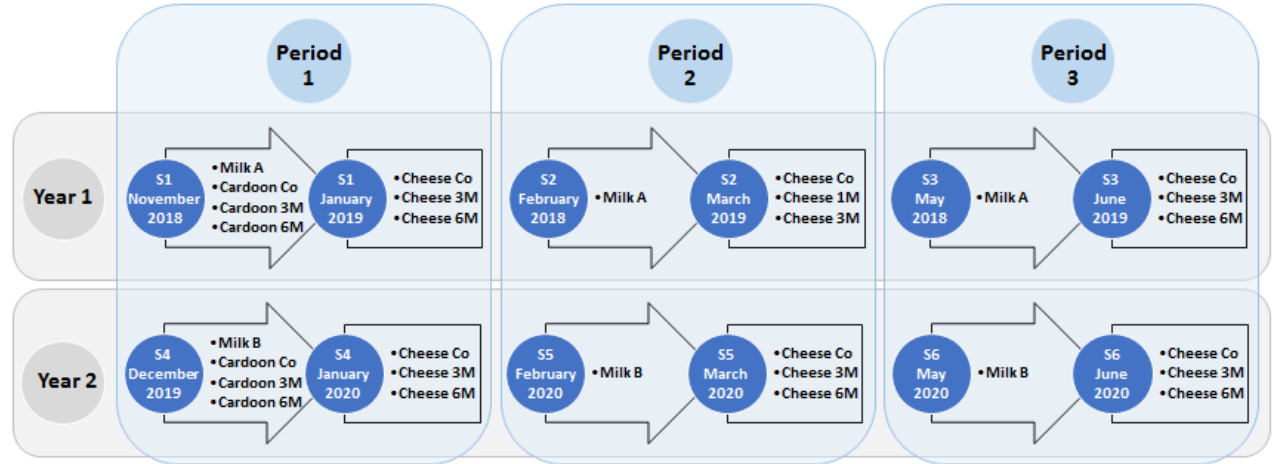
Figure 1. Schematic representation of the sampling strategy used for the microbial characterization of ewes’ raw milk, cardoon and Serra da Estrela PDO cheese. Co refers to the commercially used cardoon by the cheese producer and 1 M, 3 M and 6 M refers to specific Cynara cardunculus L. genotypes used in this study in the manufacture of Serra da Estrela cheese.